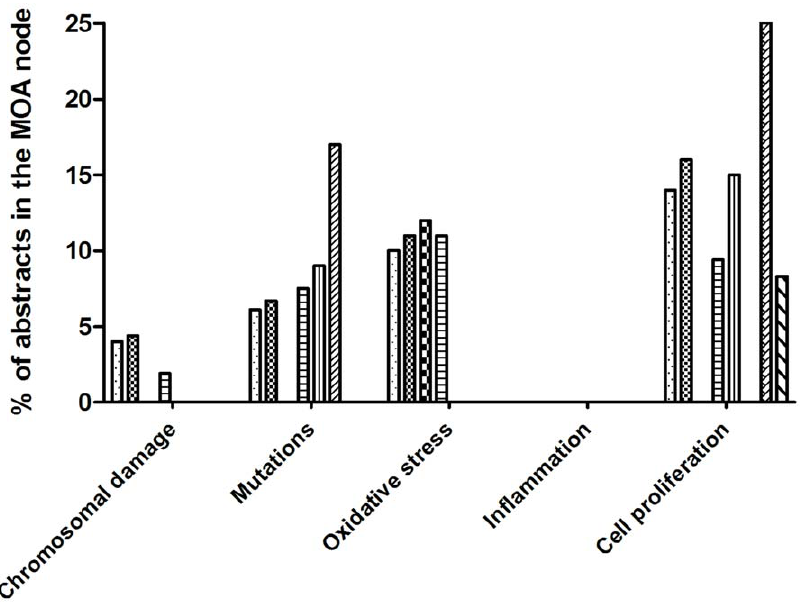
Figure 13. Distribution of classified triazole abstracts over some selected MOA nodes.